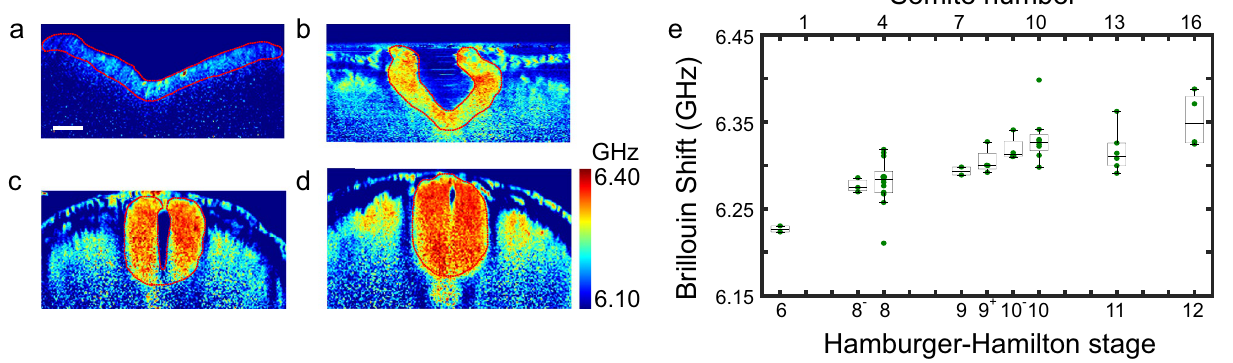
Figure 2. Results of in ovo cultured embryos. ( a–d ) Representative Brillouin images of cranial neural tube tissue of four embryos at different HH stages: ( a ) HH 6, ( b ) HH 8, ( c ) HH 11, ( d ) HH 12. Red dashed line outlines the neural plate region. ( e ) Average Brillouin shifts of cranial neural plate of embryos reveal continuous increase in tissue modulus against developmental stage. Number of embryos: 46. Each dot represents the averaged Brillouin shift of one embryo. Scale bar is 50